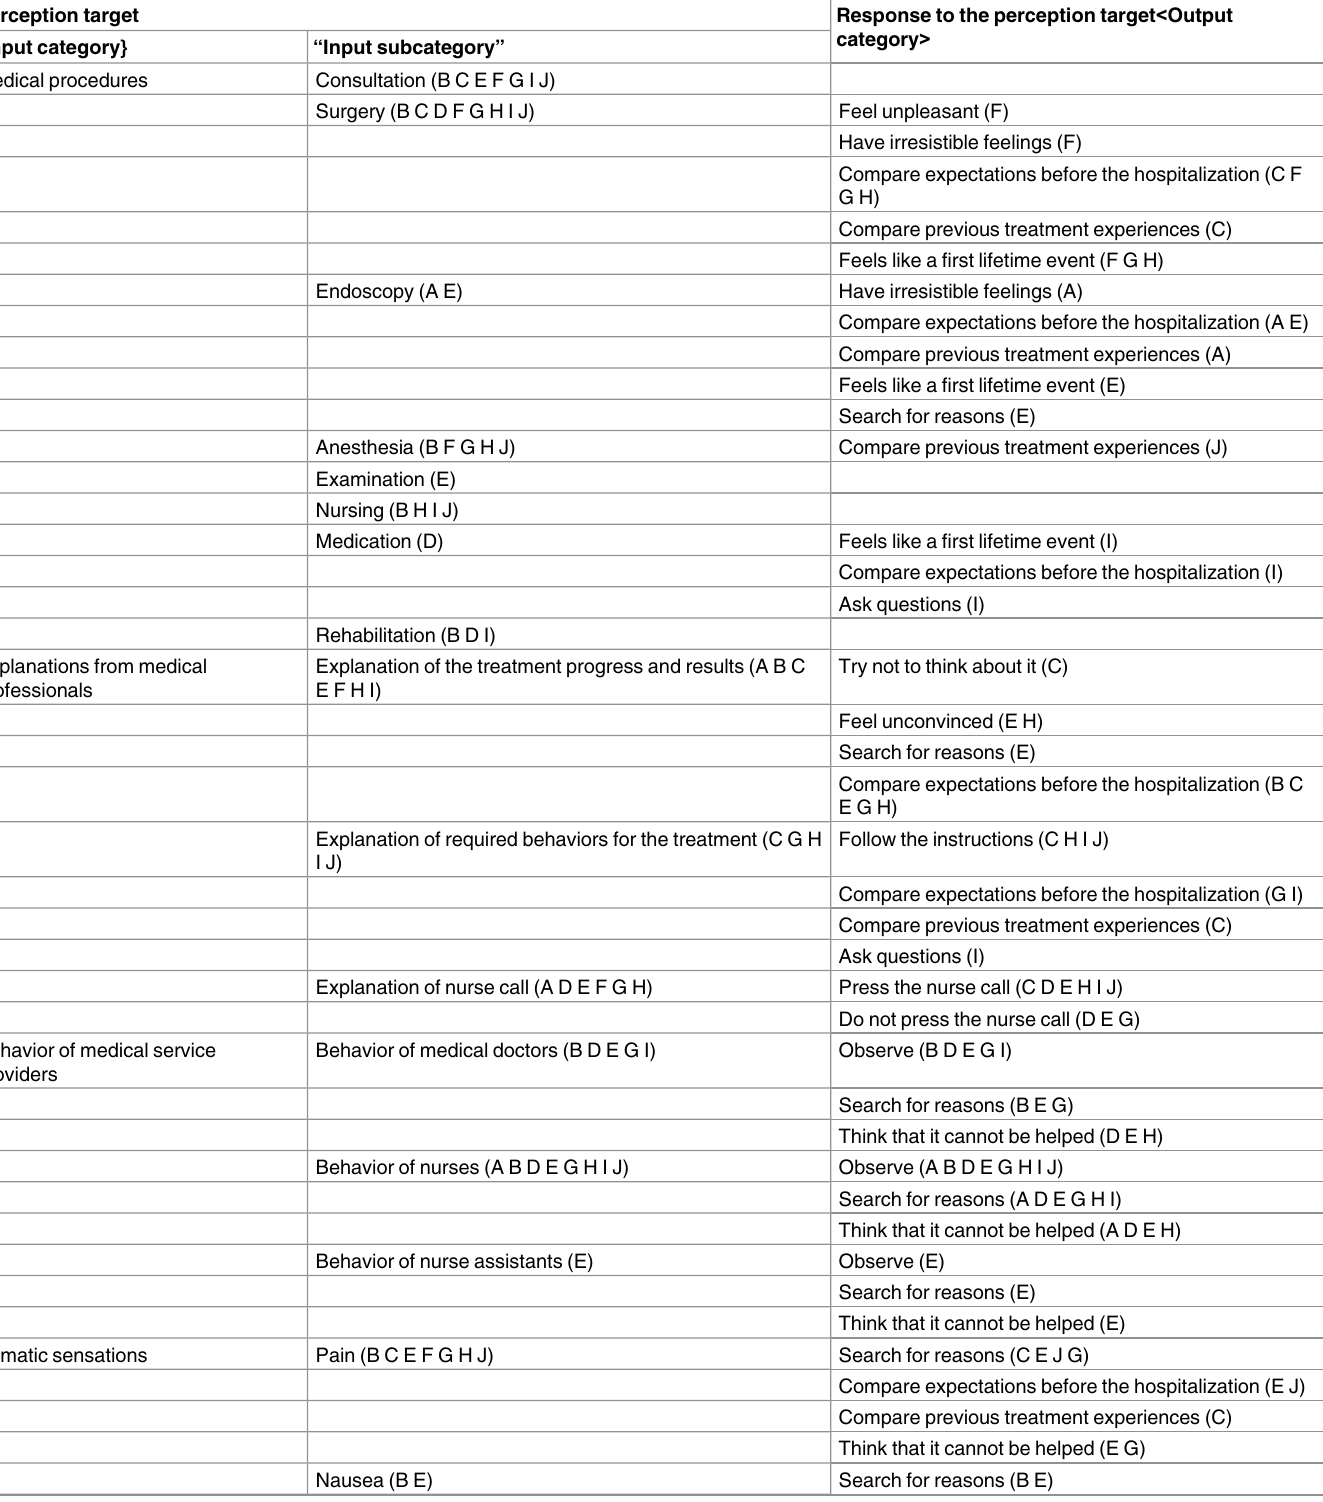
Table 1. Perception target of inpatient medical service during hospitalization and response after the